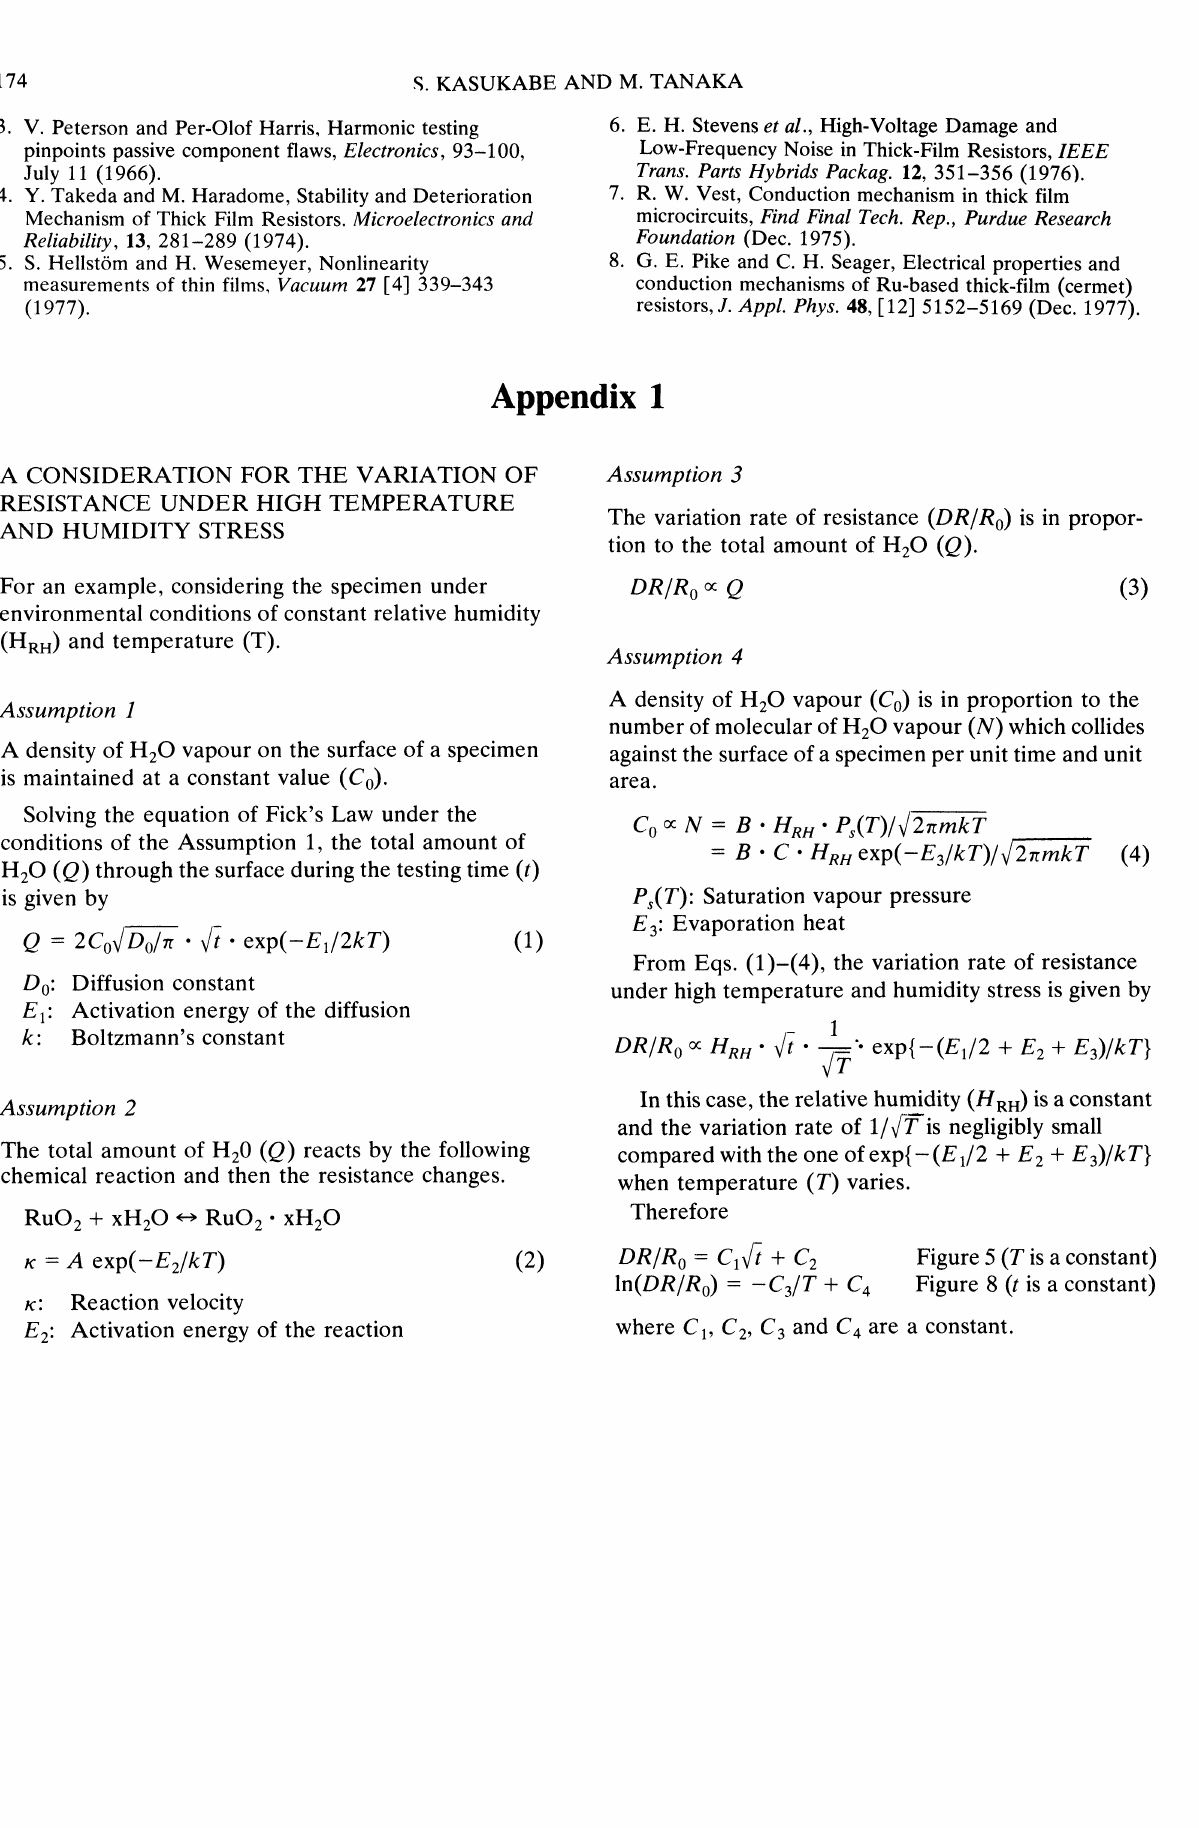
where C1, C2, C3 and C